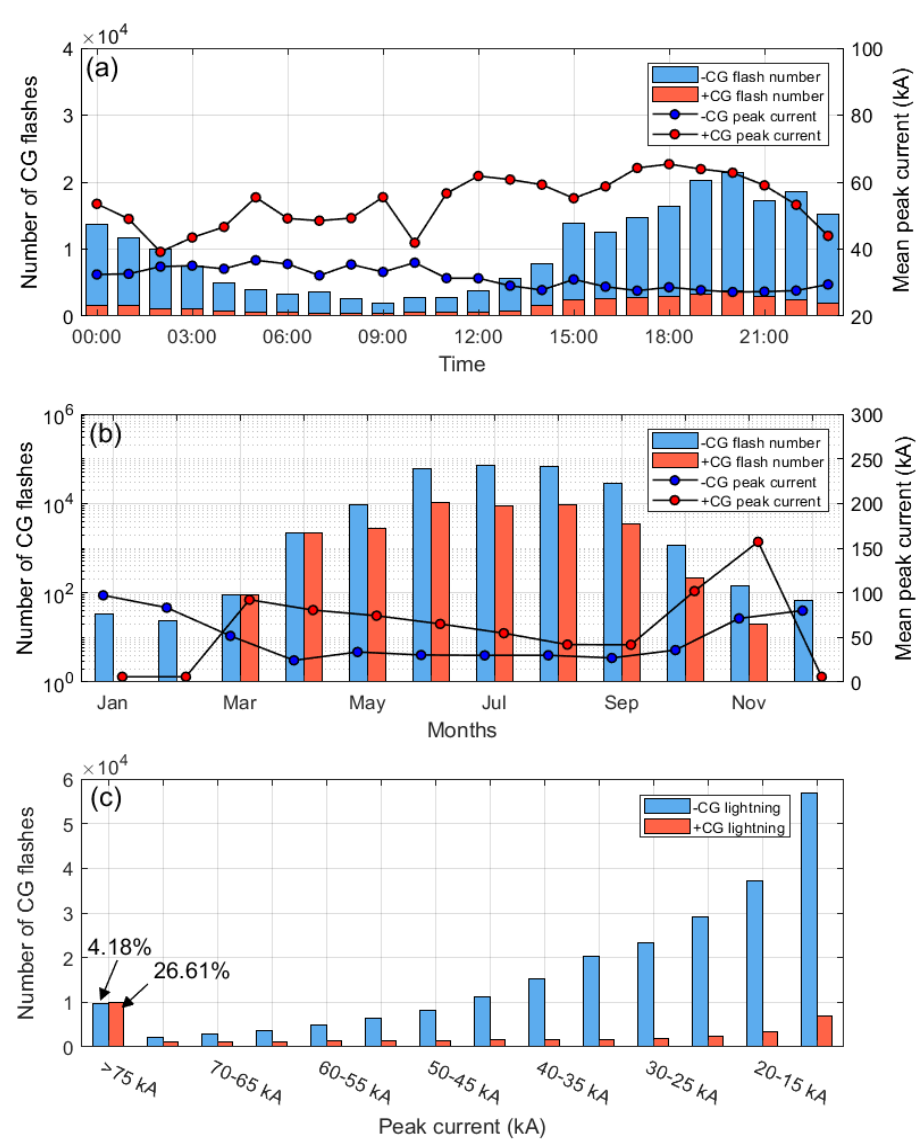
Figure 4. ( a and b ) Diurnal and monthly variations of CG flash number and mean peak current with different polarities. ( c ) Histogram of peak current intensity of positive and negative CG